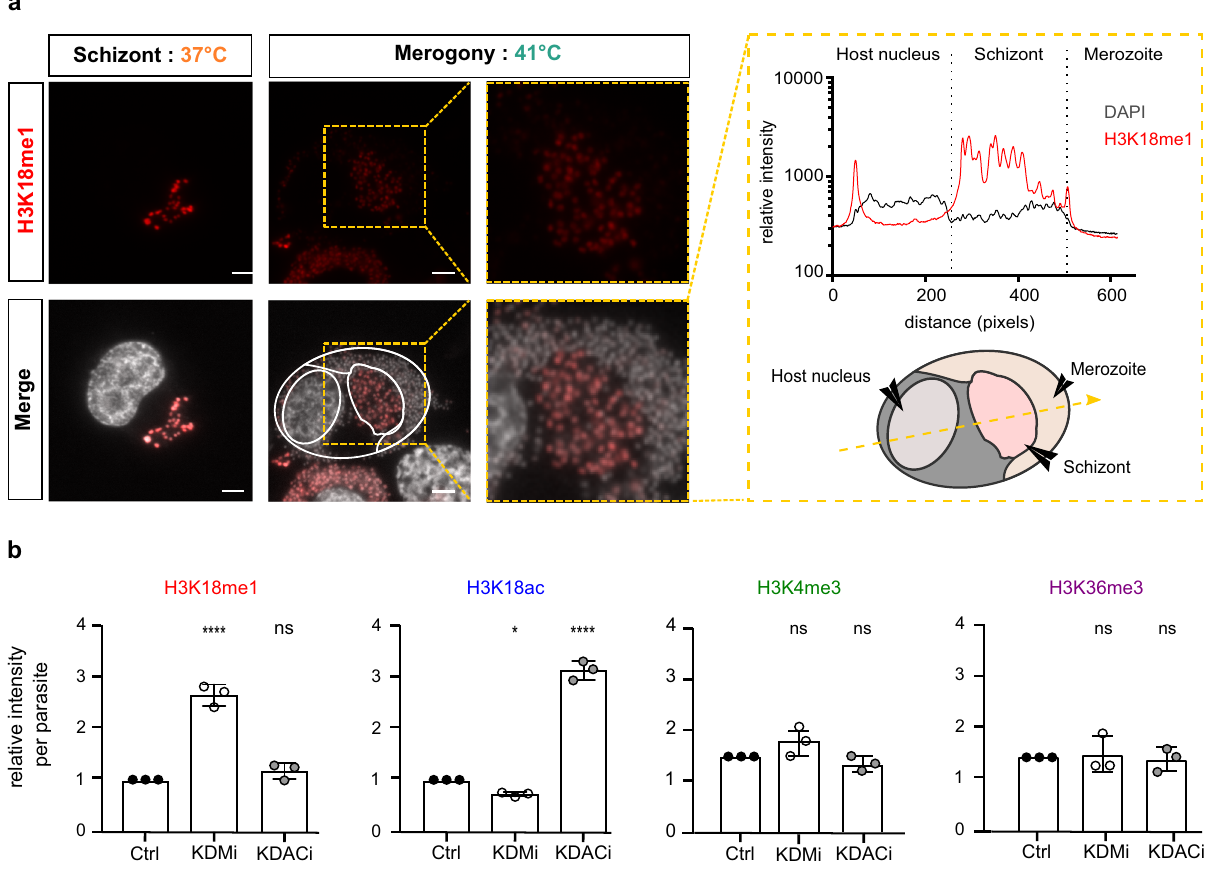
Fig. 3 H3K18 methylation is dynamic across stage transitions. a Differentiation to merozoites led to a decrease of H3K18me1 in parasite nuclei Immuno fl uorescence analysis of T. annulata infected macrophages TaC12, at 37 °C (macroschizont) and after merogony induction for 8 days at 41 °C. Host and parasite nuclei were stained with DAPI (grey) and with a speci fi c antibody for H3K18me1 (red). The yellow box shows a zoom of merogony. Leica microscope, ×100, Scale bar = 5 μ m. The right panel shows quanti fi cation of immuno fl uorescence intensity of H3K18me1 (red) compared to DNA (grey), along the yellow cross-section line, showing reduced staining in merozoites. This experiment was performed three times independently with similar results. Immuno fl uorescence replicates are included in the Source Data fi le. b Changes in the level of Histone methylation and acetylation upon treatment with inhibitors of epigenetic enzymes. Fluorescence intensity quanti fi cation of the parasite histone marks H3K18me1, H3K18ac, H3K4me3 or H3K36me3 in TaC12 cells treated with either KDMi (histone demethylase inhibitor) or KDACi (histone deacetylase inhibitor). For all experiments n = 3 biologically independent experiments that represent the mean of intensity of 50 cells per condition for each replicate. Error bars represent the mean value ± SD. Statistical Dunnett test multiple comparisons is two-sided with ns (not statistically signi fi cant) of K18m p = 0.2979/ns of K18ac p = 0.2435/ns of K4 p = 0.5060/ns of K36 p > 0.9999/**** p =